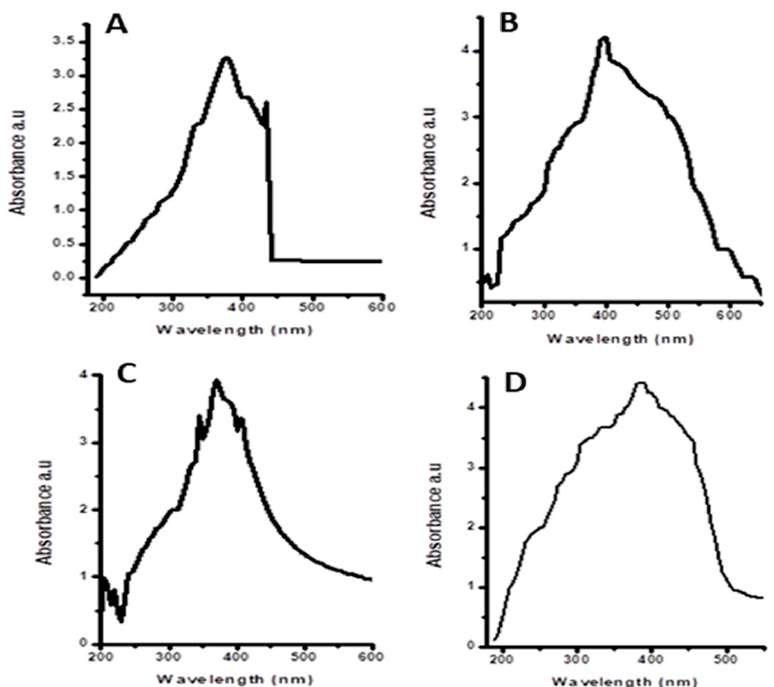
Figure 1. UV–visible absorption spectra of zinc oxide nanoparticles of leaves: ( A ) n-hexane, ( B ) ethyl acetate, ( C ) methanol, and ( D ) aqueous extracts.